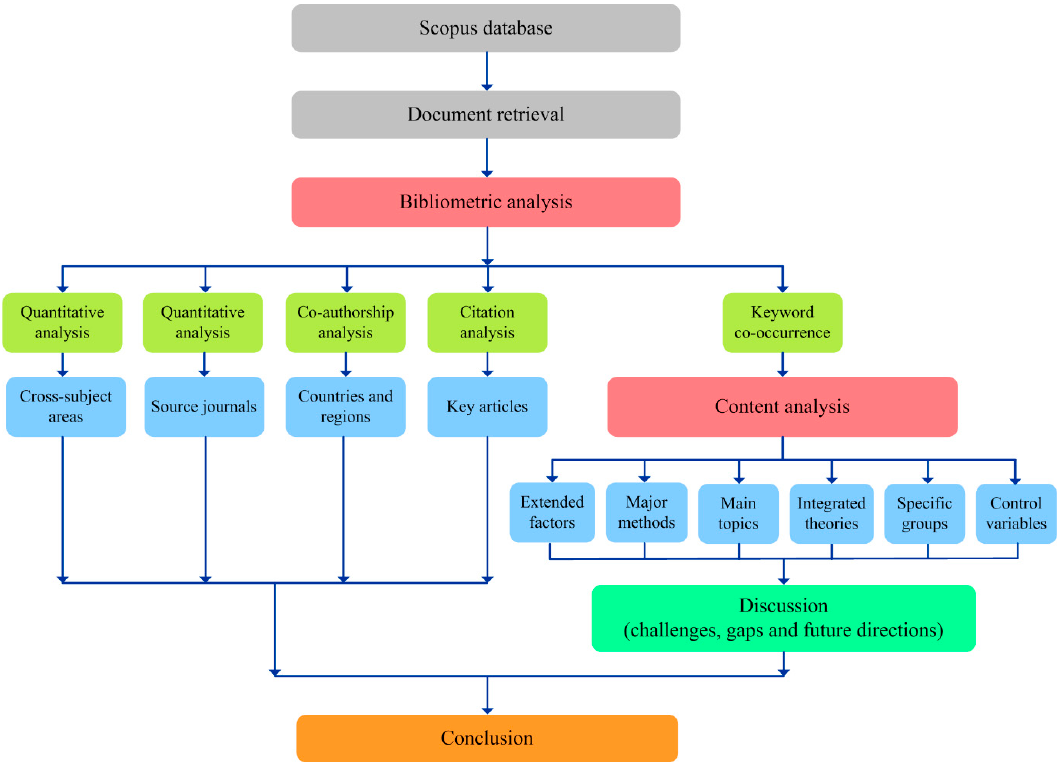
Figure 2. Research framework of the current study.